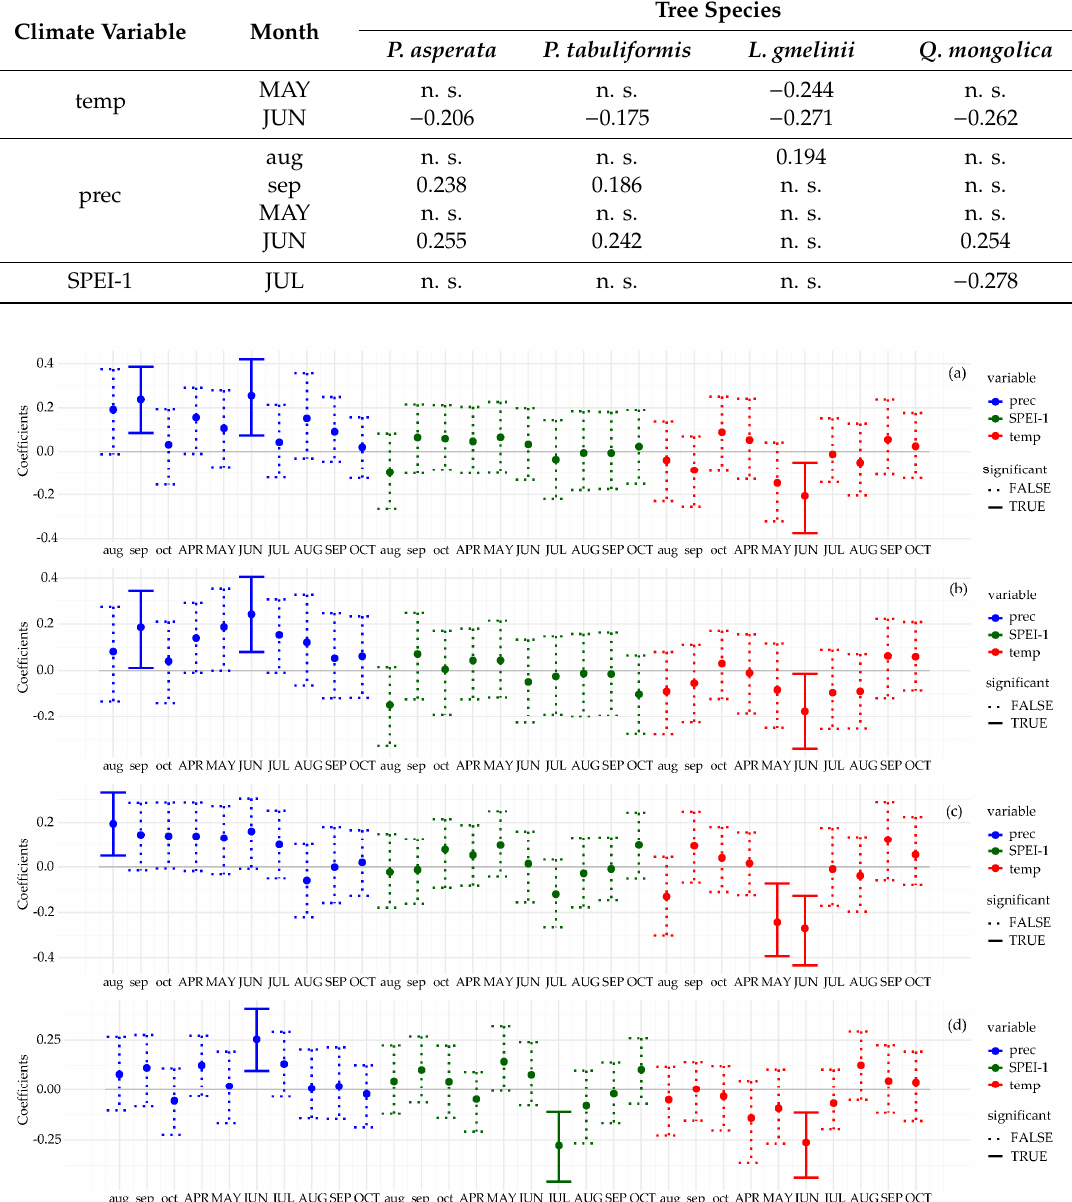
Table 4. Response coe ffi cients of monthly precipitation sums, mean monthly air temperature and SPEI–1 for the detrended ARI chronologies of the four tree species (1925–2013). Small letters represent the months of the preceding year, capital letters represent the months of the current year. N. s. = non-significant correlations.